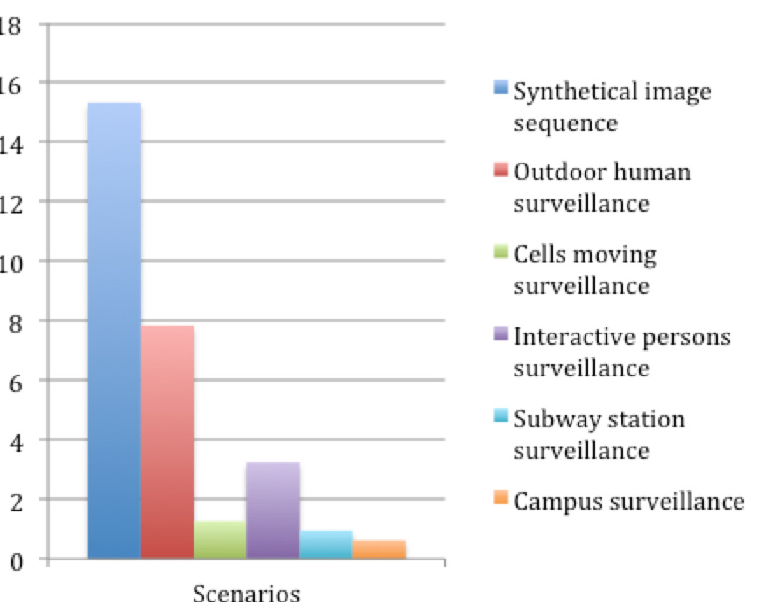
Figure 13. Processing time (unit: fps) of our tracker on the tested